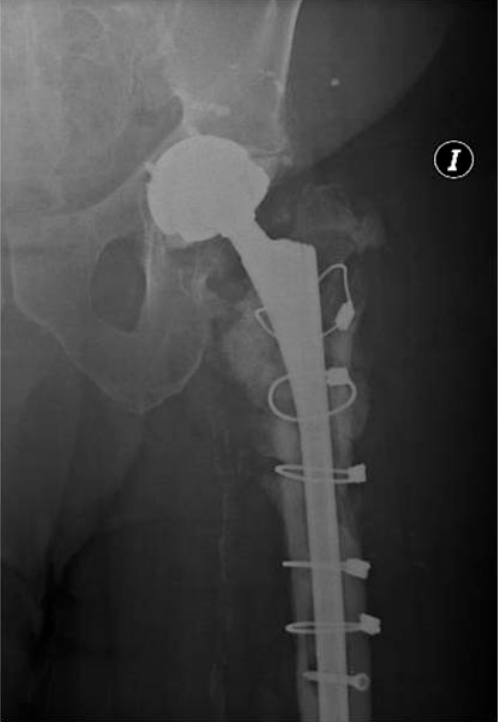
Figure 1. Hip radiography showing proximal femoral diffuse osteomyelitis and signs of non-union of his previous periprosthetic fracture.